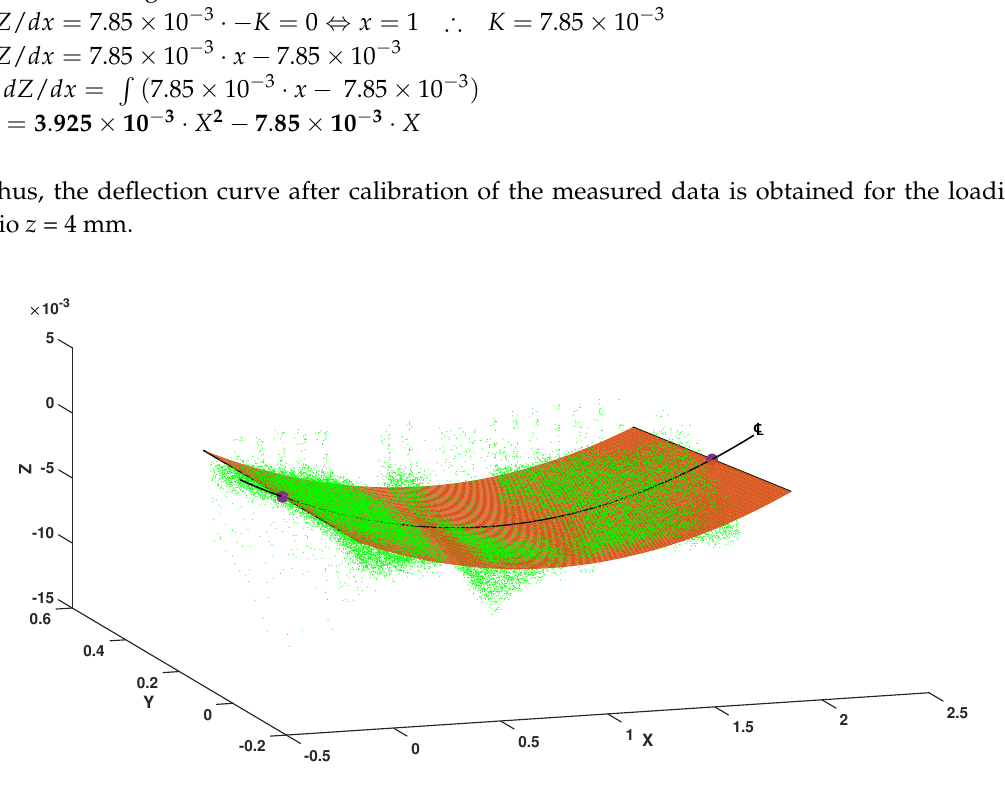
Figure 12. deflected shape of flange entity with deflection curve at the enter